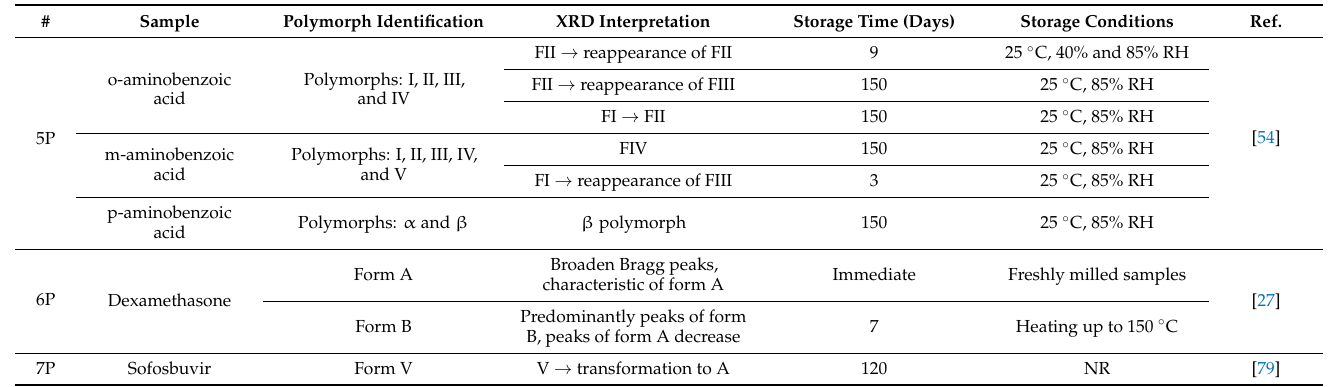
Table 16. Overview of structural stability of polymorphs upon storage in diverse